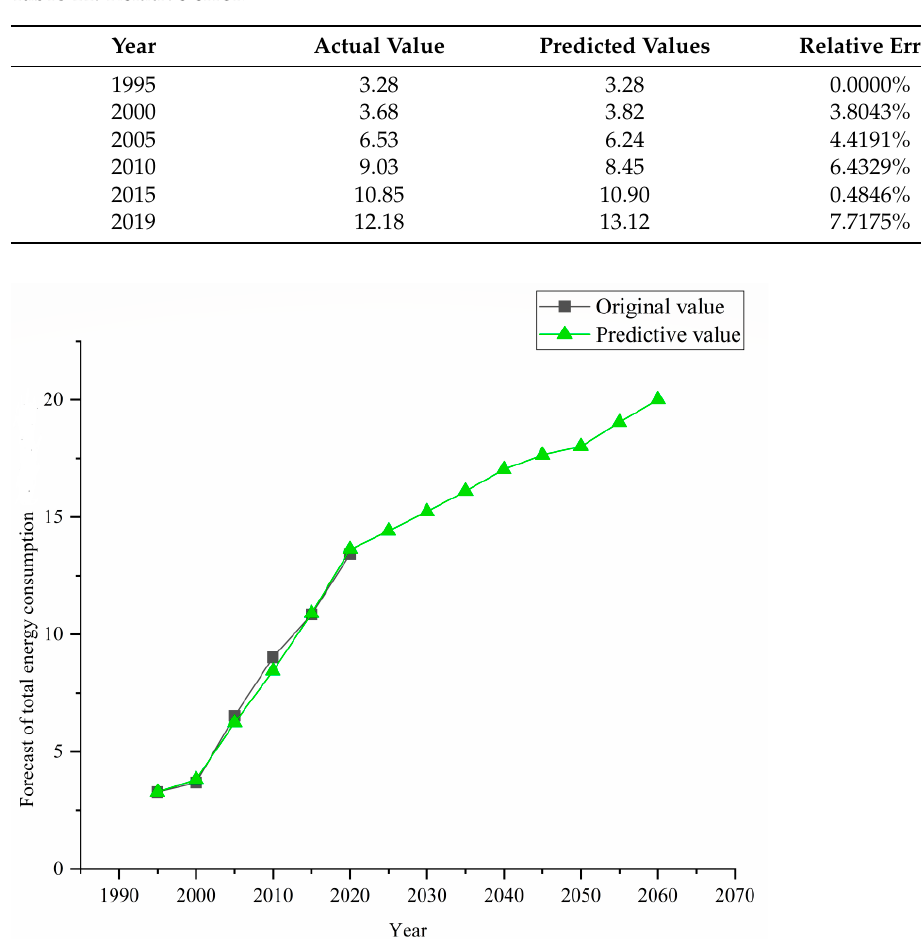
Table 11. Relative error.